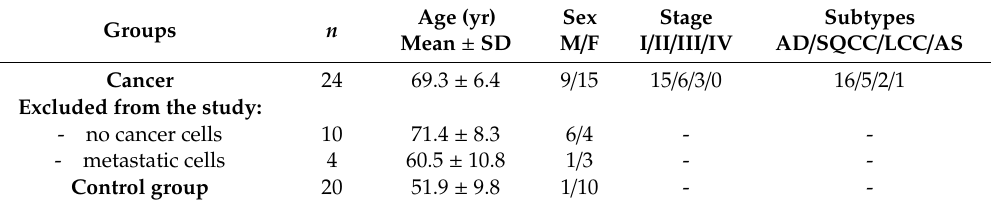
Table 1. Demographic details of lung cancer patients and control